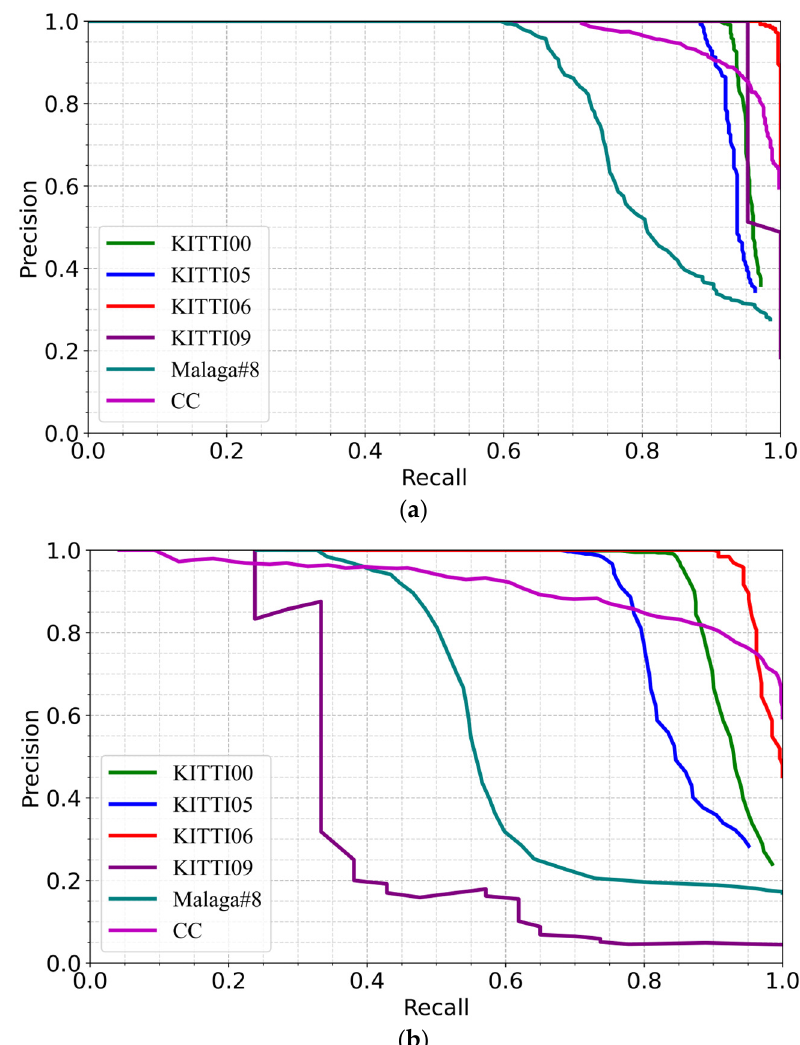
Figure 5. The Precision-Recall curves of the two branches on six datasets. ( a ) Global feature rank- ing branch. ( b ) Semantic edge feature ranking branch. branch. ( b ) Semantic edge feature ranking